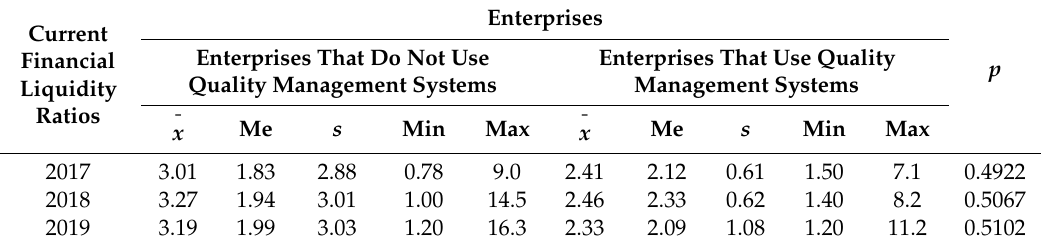
Table 1. Average results for current financial liquidity ratios in 2016–2018.